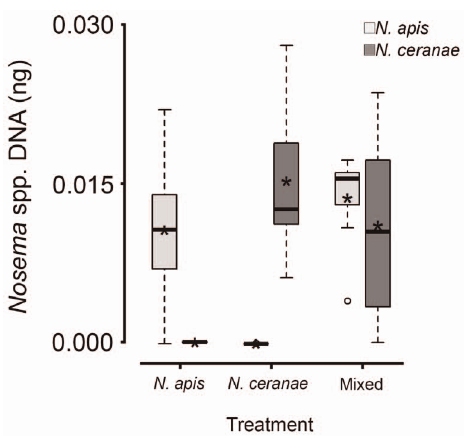
Figure 3. Level of Nosema infection in dead adult worker western honey bees ( Apismellifera ) 28–30 d post oral inocula- tion for control, Nosemaapis , Nosemaceranae and mixed N.apis / N. ceranae treatments. Boxplots show interquartile range (box), median (black line within interquartile range), data range (dashed vertical lines), and outliers (open dots); asterisks (black) represent means. Horizontal square parenthesis under boxplots indicates a significant difference; controls were excluded from analyses because no infections were observed.